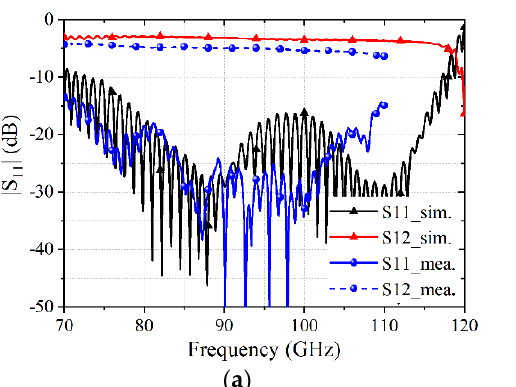
Table 2. Comparison among the transitions from the transmission line to rectangular waveguide.